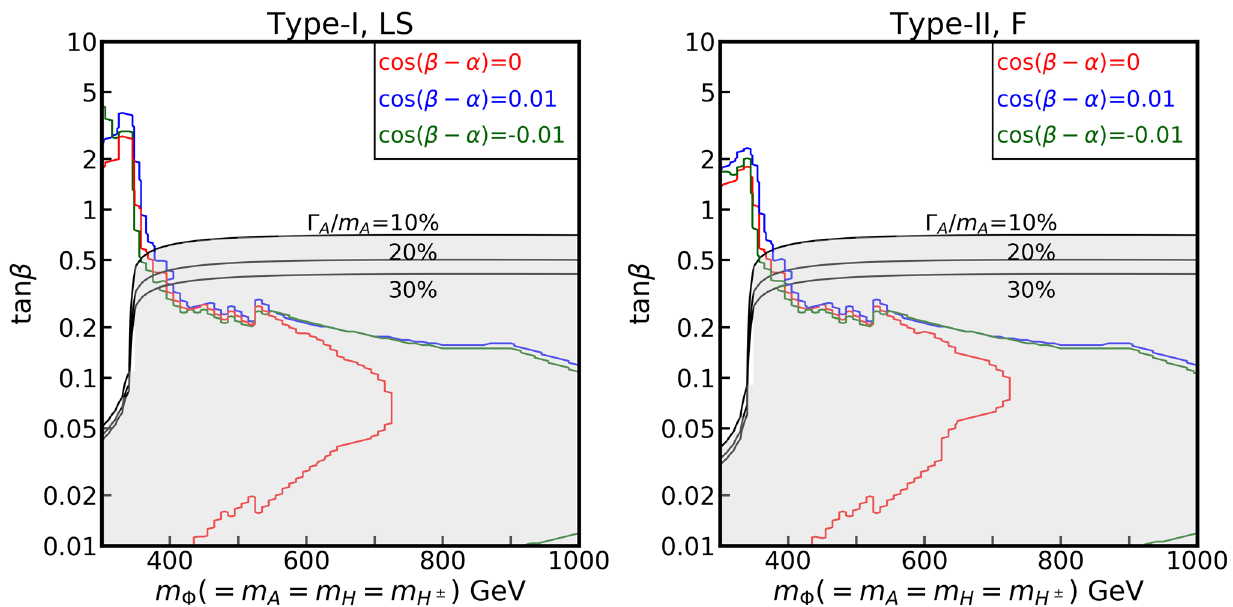
Fig. 7 Study in the m φ -tan β plane. Here we choose the benchmark parameter cos (β − α) = 0 (red line), 0.01 (blue line) − 0.01 (green line). The left is for the Type-I, LS 2HDM and right for the Type-II,